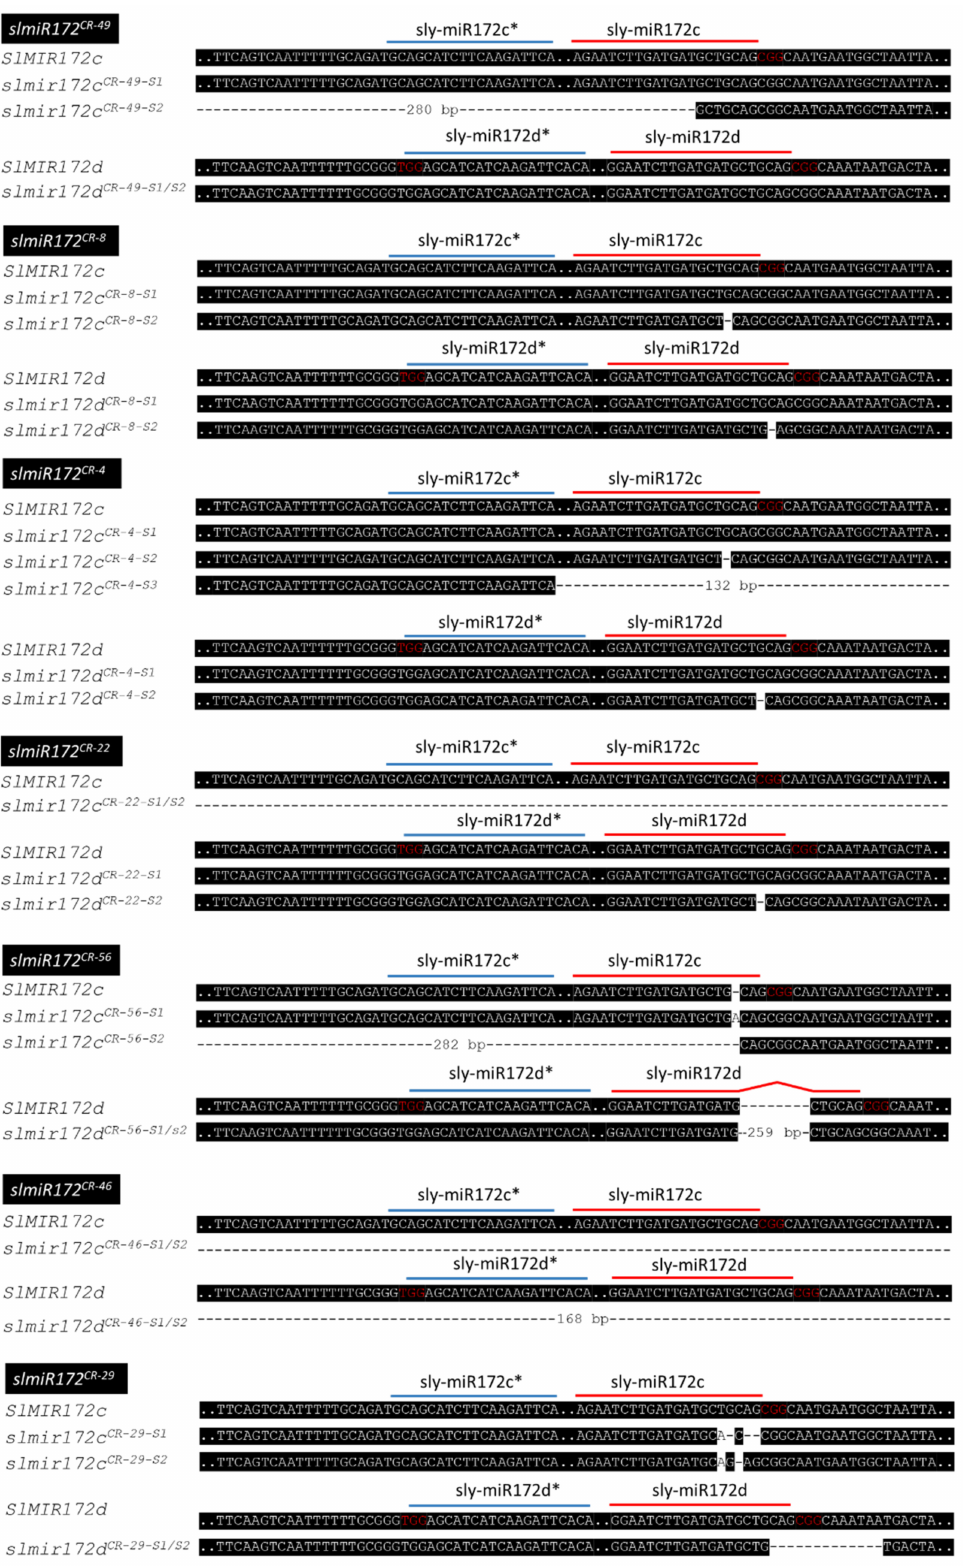
Figure A2. Multiple sequence alignments between wild-type SlMIR172c and SlMIR172d and respective CRISPR alleles ( slmir172c-d CR ) that were recovered from the primary transformants. Transgenic plant number (CR-#) and sequenced mutant alleles (S) are indicated. The respective sly-miR172 and sly-miR172* sequences are indicated and the PAM sequences are colored in red. Numbers indicate the size of deletion in base